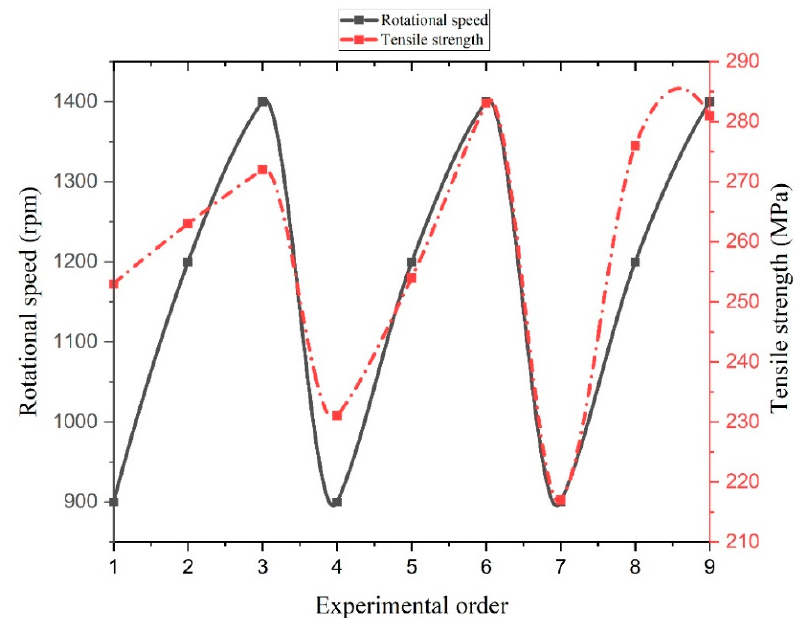
Figure 6. Effects of rotational speed on the tensile strength property of AA 6061.